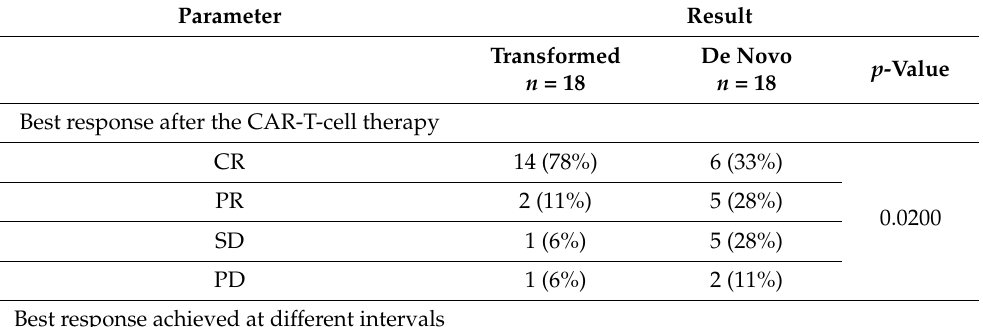
Table 4. Clinical course and characteristics of the patients after CAR-T-cell therapy. Comparison of the two groups of patients with transformed versus de novo lymphoma. The p -values were calculated using Chi-square